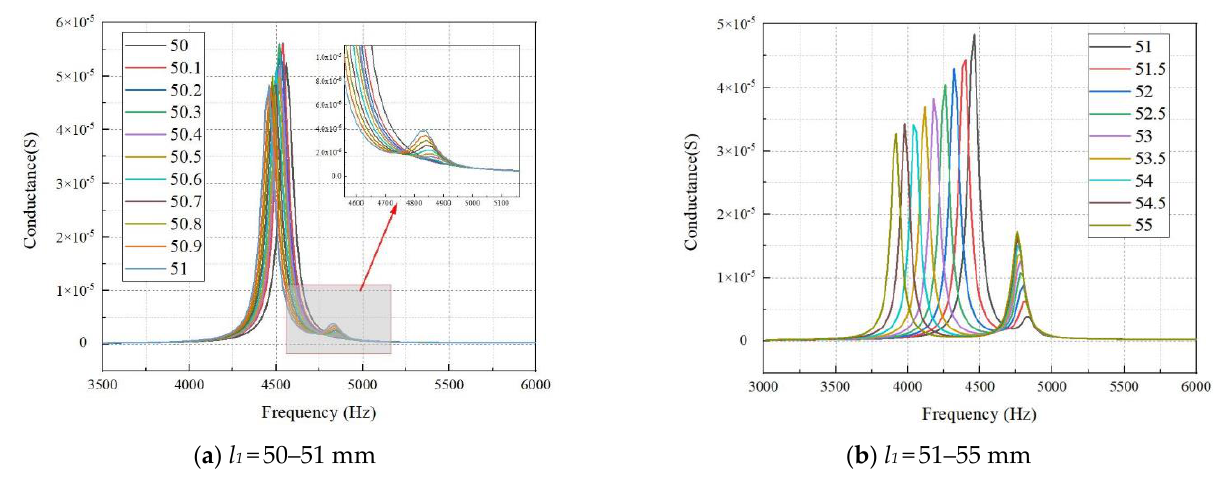
Figure 6. Conductance curve with different l 1 ( l 2 = 50 mm).